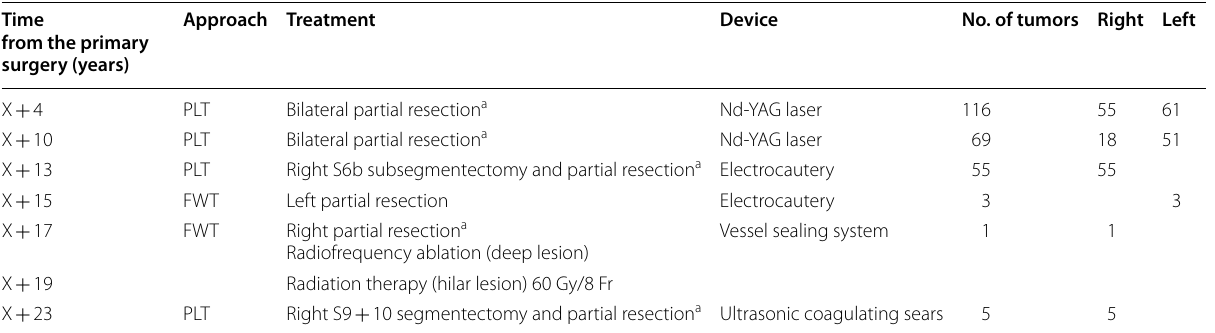
PLT posterolateral thoracotomy, FWT French window thoracotomy, Nd-YAG laser neodymium:yttrium–aluminum-garnet laser a Pulmonary partial resection was performed without stapling